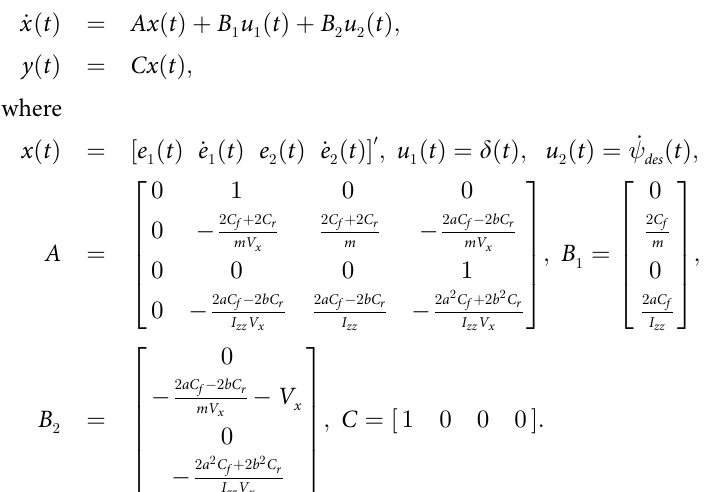
Fig 2. Tire cornering stiffness. (A) Corresponding lateral tire force, F the function (red line) when the vertical tire load is 3187.16 N, considering the vehicle mass, i.e., 967 N/deg or 55405 N/rad, which are both values of tire cornering stiffness C and C , r f